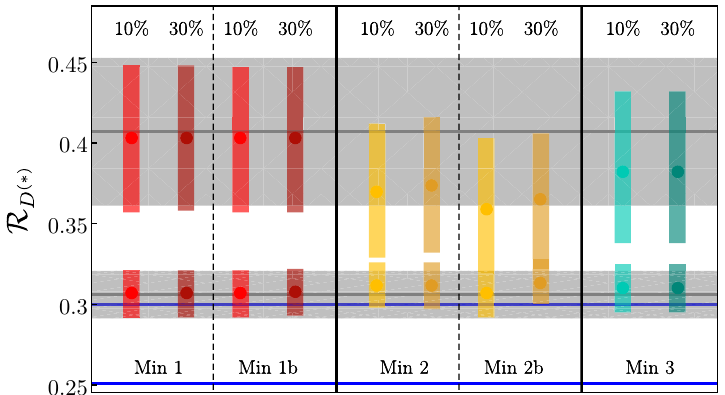
Figure 4 . Predictions for (higher numerical values) and (lower numerical values) for R D R D ∗ , with ( B c τ ¯ ν τ ) 10% the minima obtained in the fit, both with and without including F D ∗ L B → ≤ τ ¯ ν τ ) 30%. The experimental values are represented by the horizontal black lines, and ( B c → ≤ B with their corresponding uncertainties (grey bands). The blue lines show the SM predictions, = 0 . 300 +0 . 005 (upper blue line) and = 0 . 251 +0 . 004 (lower blue line). 0 . 004 0 . 003 R D R D ∗ − − and their q 2 distributions, while Min 3 fits perfectly, but is R D ( ∗ ) R D ( ∗ )